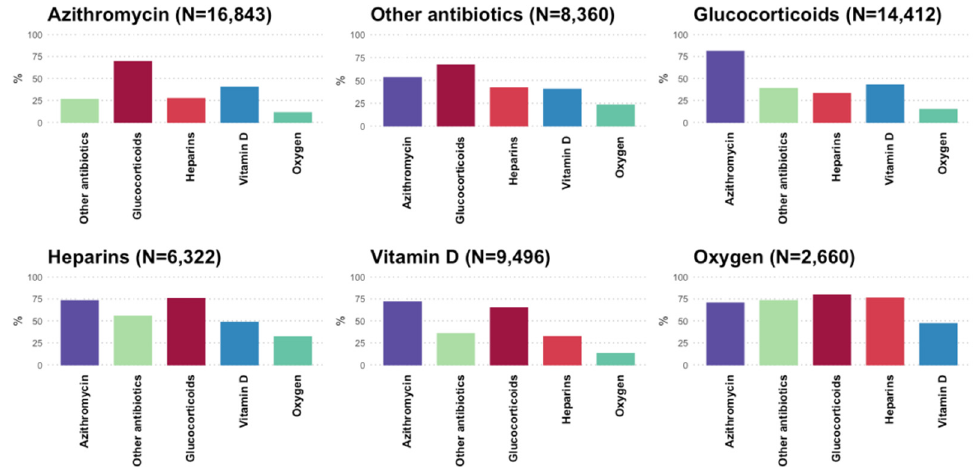
Figure 4. Frequency (%) of co-prescribed study drugs in Caserta Local Health Unit on the total number of each study drug users, in patients with a SARS-CoV-2 infection diagnosis that occurred in the period 21 February 2020–31 January 2021, stratified by active substance/drug